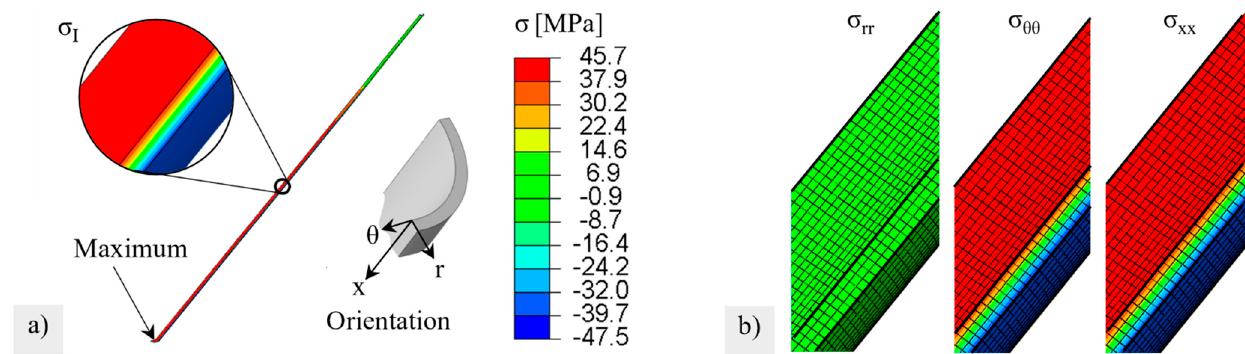
Figure 13. Stress distribution after pressure relieve and 10% cooling within 120 s: ( a ) maximum principal stress ( b ) stress components at the relative membrane length x = 0.5. The color legend is valid for ( a , b